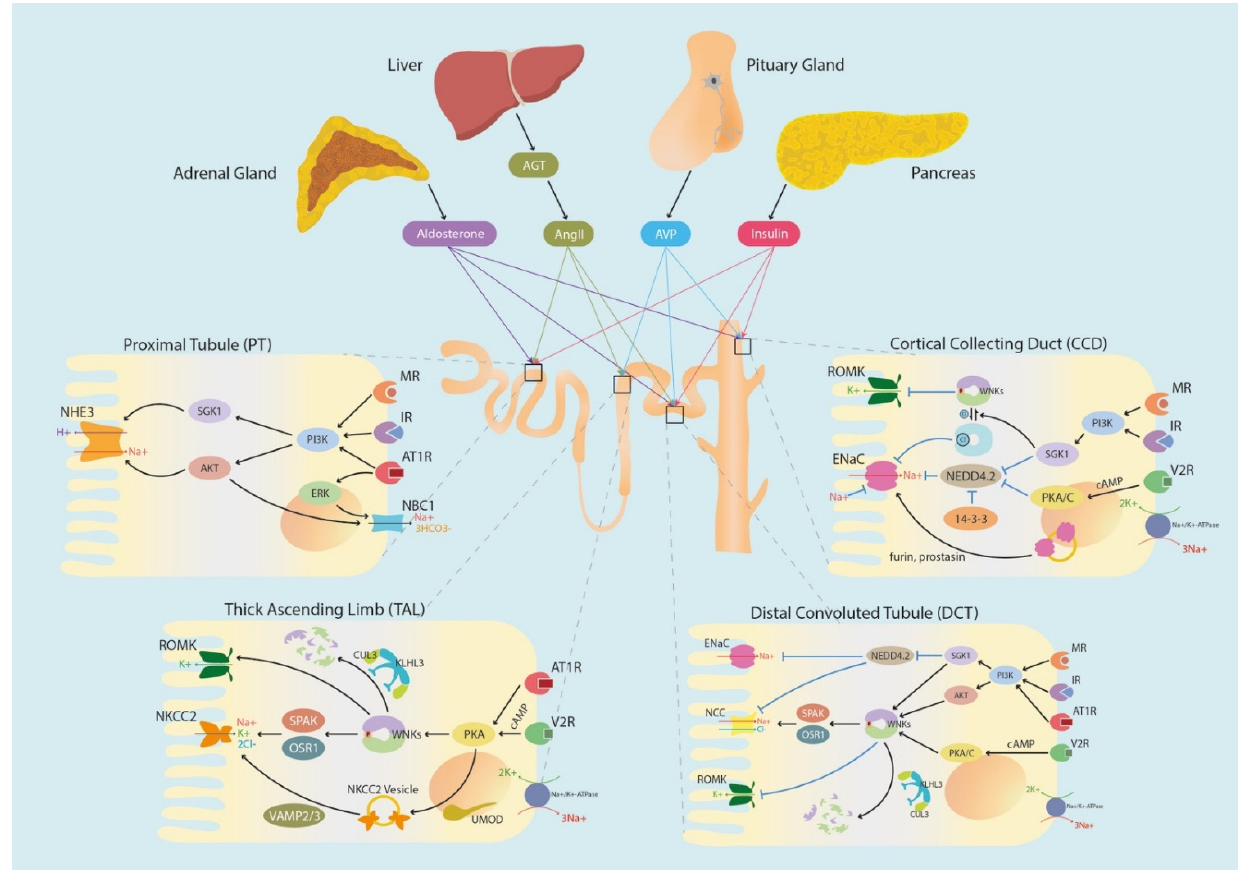
Figure 4. Hormonal and cellular regulation pathway of ion channels along renal segments.